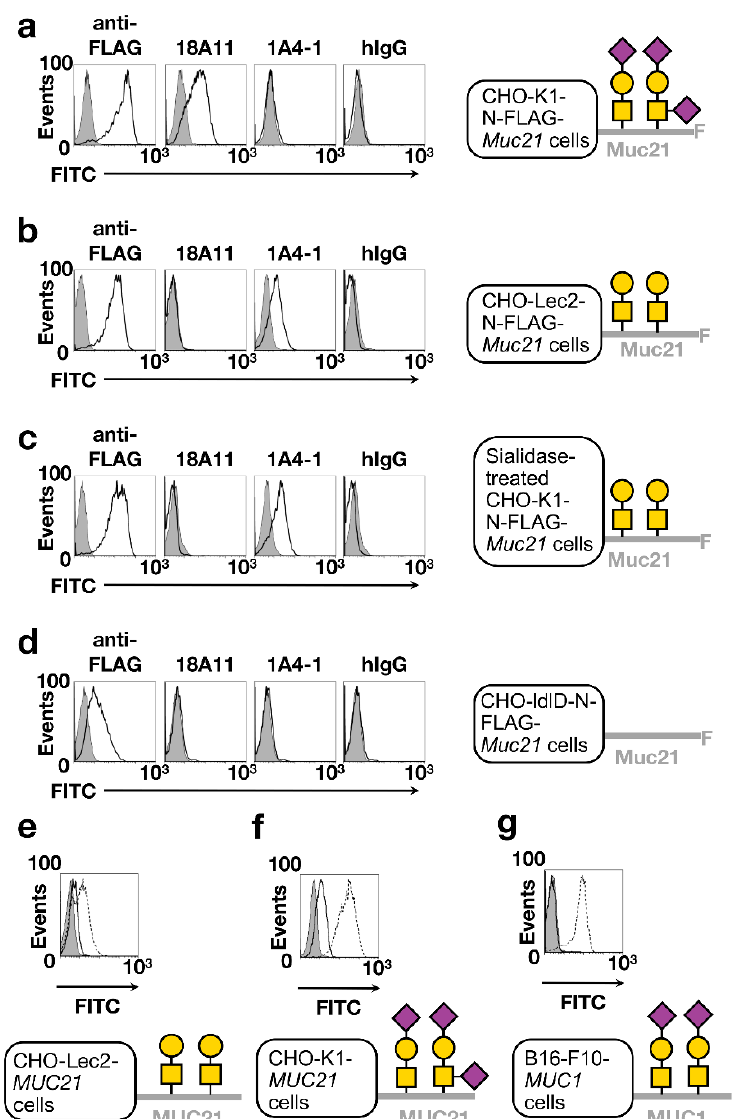
Figure 3. Binding of mAbs 1A4-1 and 18A11 to Muc21 transfectants expressing different glycoforms. ( a – d ) Flow cytometric analysis with anti-FLAG mAb, mAb 18A11, mAb 1A4-1 and hamster IgG. In each case, mock transfectants were used as controls. Control cells received the same enzyme treatment as Muc21 transfectants. Shaded area represents antibody binding to control. Black line represents antibody binding to Muc21 transfectants. ( a ) CHO-K1-pcDNA3.1-N-FLAG- Muc21 cells. ( b ) CHO-Lec2-pCAGGS-N-FLAG- Muc21 cells. ( c ) Sialidase-treated CHO-K1-pcDNA3.1-N-FLAG- Muc21 cells. ( d ) CHO-ldlD-pCAGGS-N-FLAG- Muc21 cells. ( e ) CHO-Lec2-pCAGGS- MUC21 cells. Shaded area represents hamster IgG, black line mAb 1A4-1, and dashed black line mAb heM21C. ( f ) CHO-K1-pcDNA3.1- MUC21 cells. Shaded area represents hamster IgG, black line mAb 18A11, and dashed black line mAb heM21C (specific to Tn, T, and sialyl T-MUC21). ( g ) B16-F10- MUC1 cells. Shaded area represents hamster IgG, black line mAb 18A11, and dashed black line mAb MY.1E12 (specific to sialyl